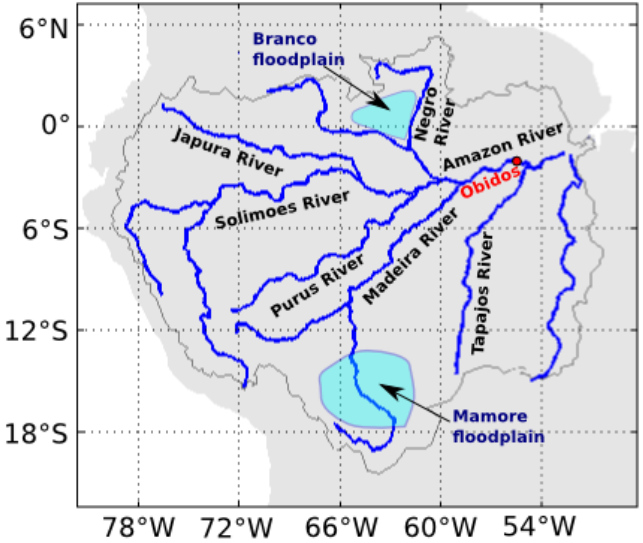
Figure 1. Map of the Amazon Basin with the main rivers and